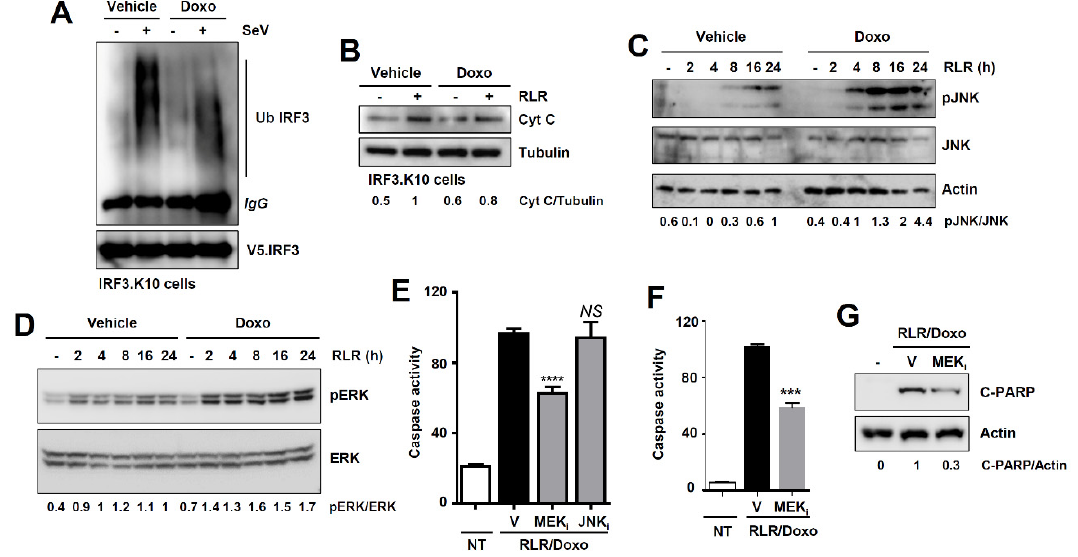
Figure 6. Doxorubicin promotes RIPA by activating the extracellular signal-regulated kinase (ERK) signaling pathway. ( A ) IRF3 − / − cells expressing IRF3 K10 mutant were infected with Sendai virus (SeV) in the absence or the presence of doxorubicin, and ubiquitination of IRF3 was analyzed. ( B ) IRF3 − / − cells expressing IRF3 K10 mutant were transfected with polyI:C (RLR) in the absence or presence of doxorubicin. The mitochondria-free cytosol was analyzed for cytochrome c (Cyt C) by immunoblot. ( C , D ) MDA-MB-453 cells were transfected with polyI:C (RLR) in the absence or presence of